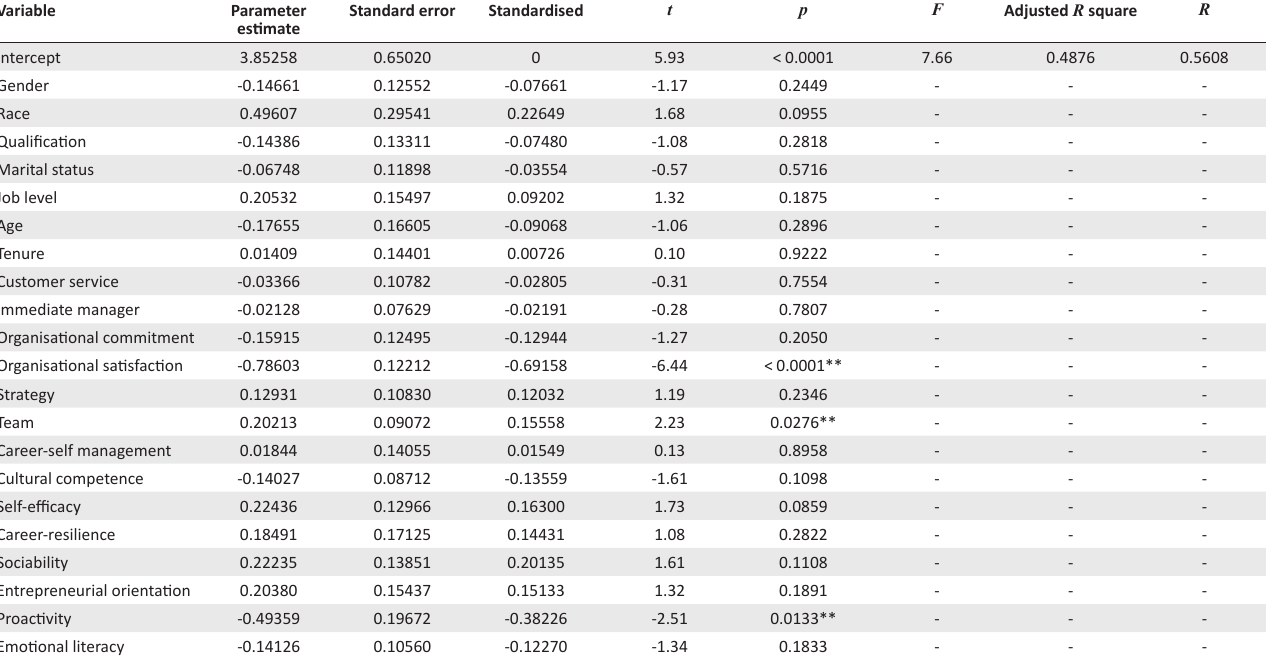
TABLE 5: Multiple regression statistics summary: Burnout as dependent variable and employee engagement, self-perceived employability and demographics as independent variables. Variable